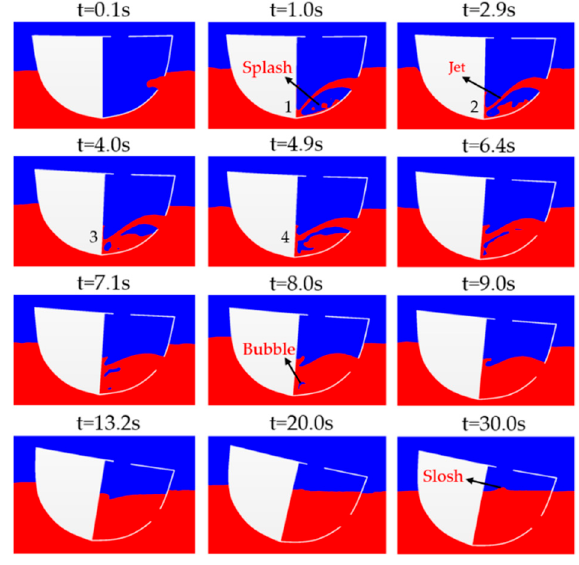
Figure 12. Visualization of the side flooding process.